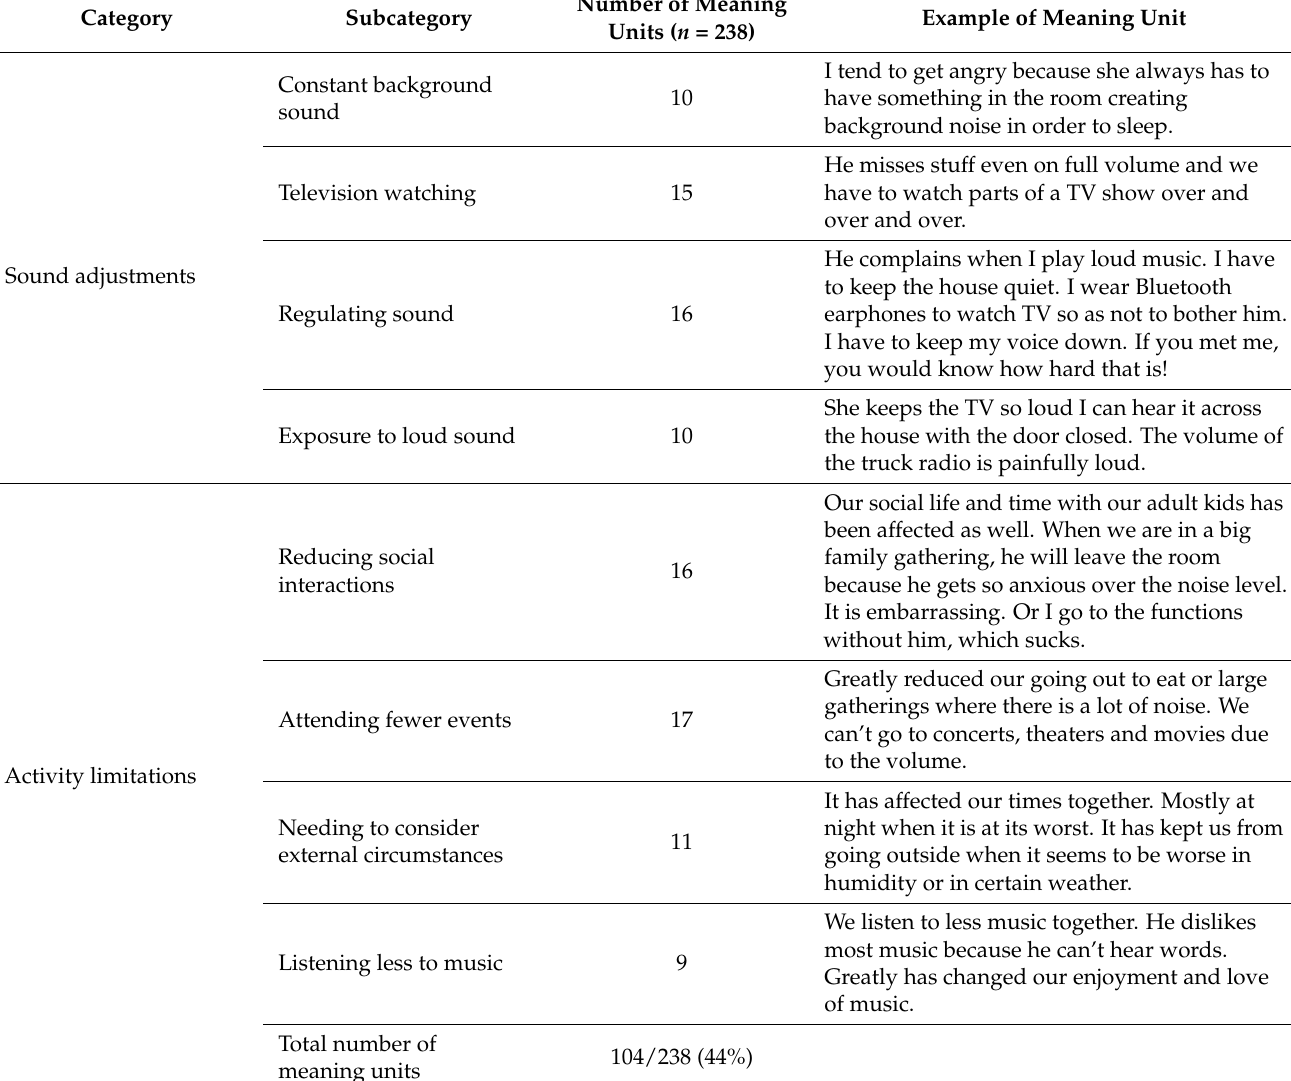
Table 3. The impact of tinnitus on significant